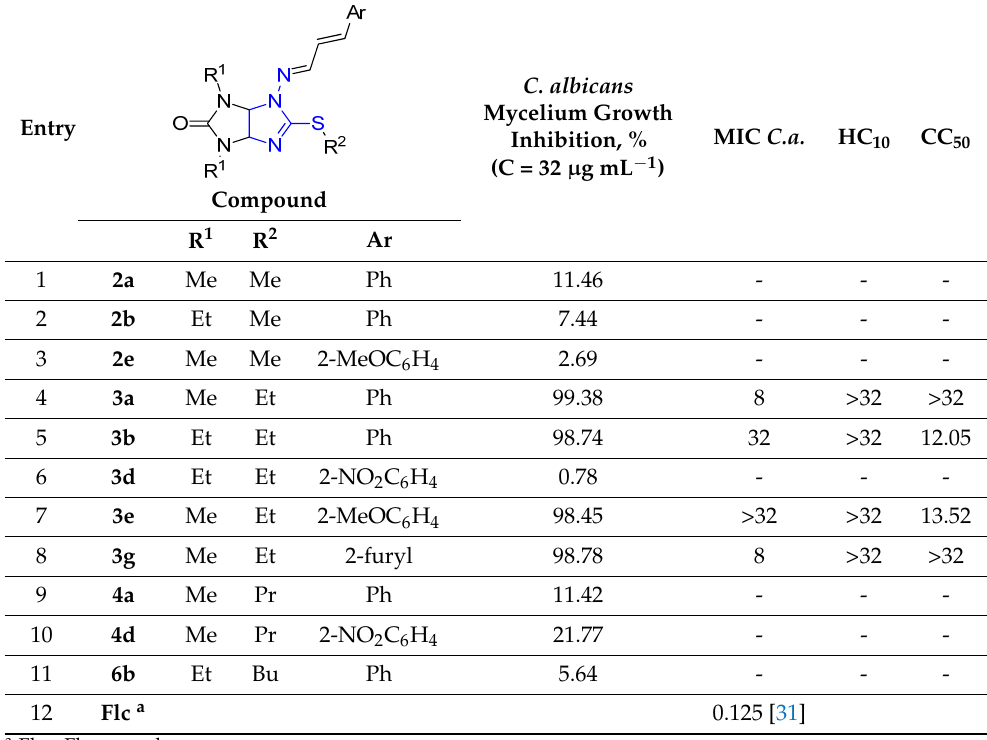
Figure 3. Venturia inaequalis ( V. i .), Rhizoctonia solani ( R. s .), Fusarium oxysporum ( F. o .), Fusarium moniliforme ( F. m .), Bipolaris sorokiniana ( B. s .), and Sclerotinia sclerotiorum ( S. s .) mycelium growth inhibition under treatment with triadimefon and S-alkyl derivatives 6a , 6c , 6e , and 6g . Table 2. In vitro fungicidal activity of compounds 2a,b,e, 3a,b,d,e,g, 4a,d, and 6b against C. albicans . The minimum inhibitory concentration (MIC) and cytotoxicity on human embryonic kidney cells (HEK-293, CC 50 ) and human red blood cells (RBC, HC 10 ) are expressed in µ g mL − 1 .